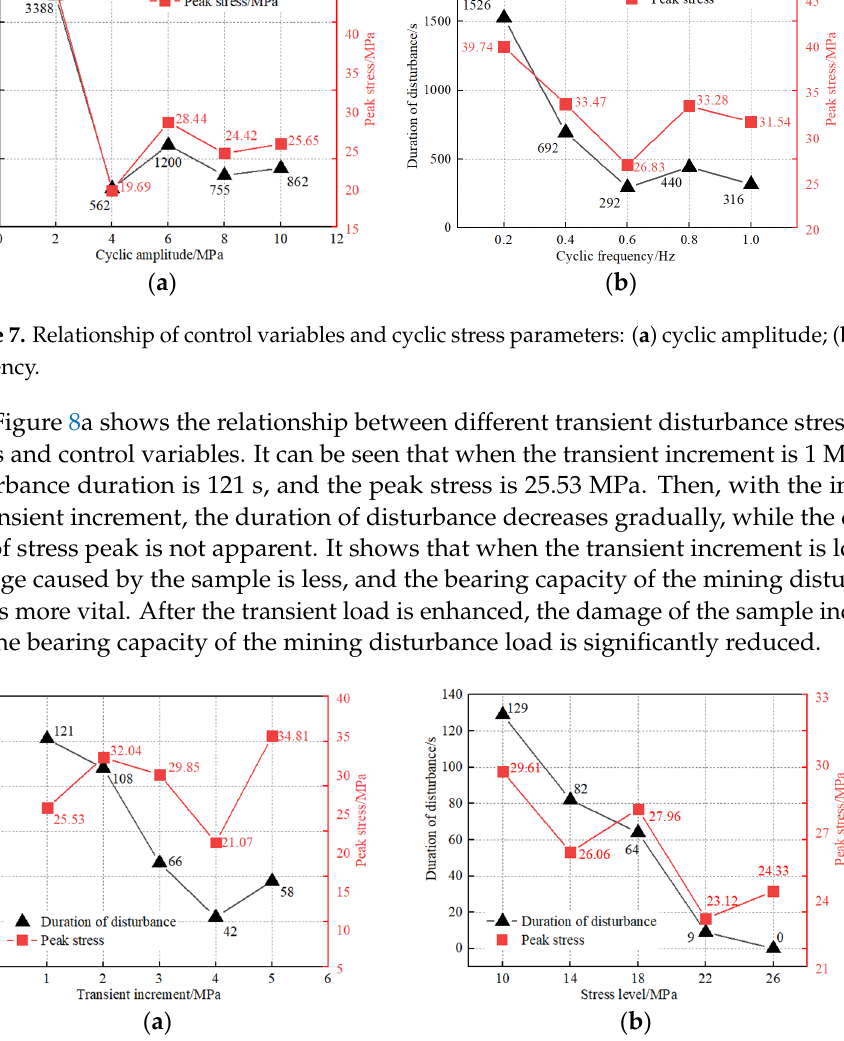
Figure 7. Relationship of control variables and cyclic stress parameters: ( a ) cyclic amplitude; ( b ) c yclic frequency.